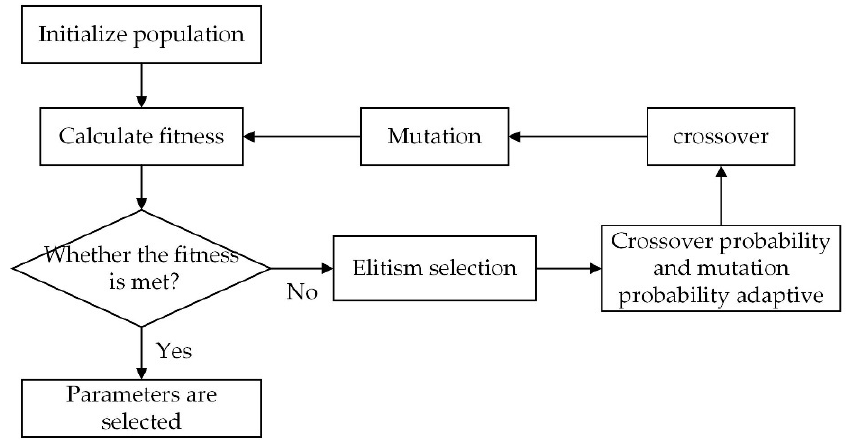
Figure 3. AGA algorithm flow.